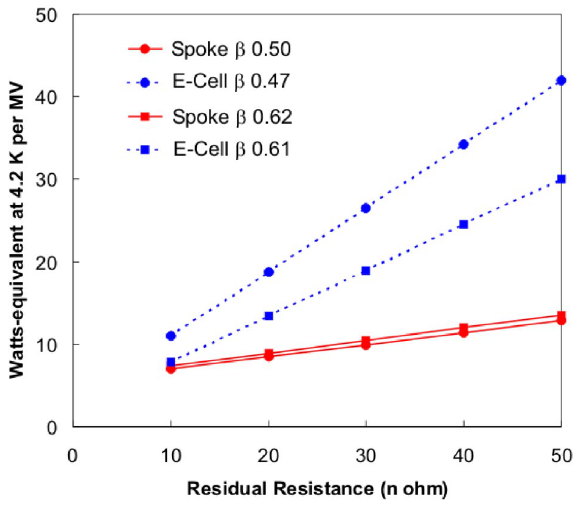
FIG. 3. (Color) A rf load into helium refrigeration as a func- tion of cavity performance for operation at a peak surface electric field of 27 : 5 MV = m . See text for